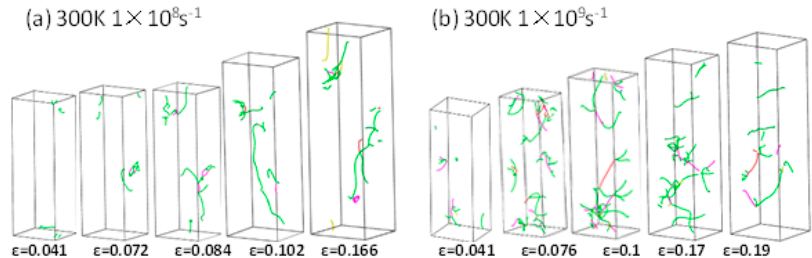
Figure 9. The DXA diagram of non-GBs HEAs under tensile. ( a ) 300 K, 1 × 10 8 s − 1 ; ( b ) 300 K, 1 × 10 9 s − 1 .